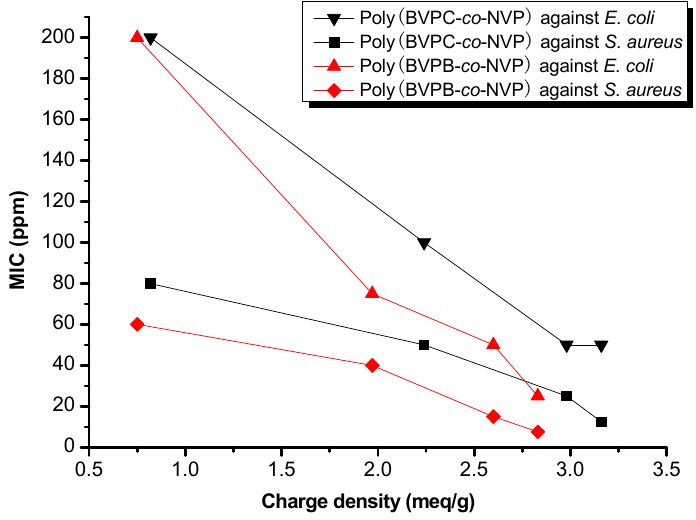
Figure 4. Minimum inhibition concentration of quaternized poly(4VP- co -NVP) against S. aureus and E. coli on the function of charge density.